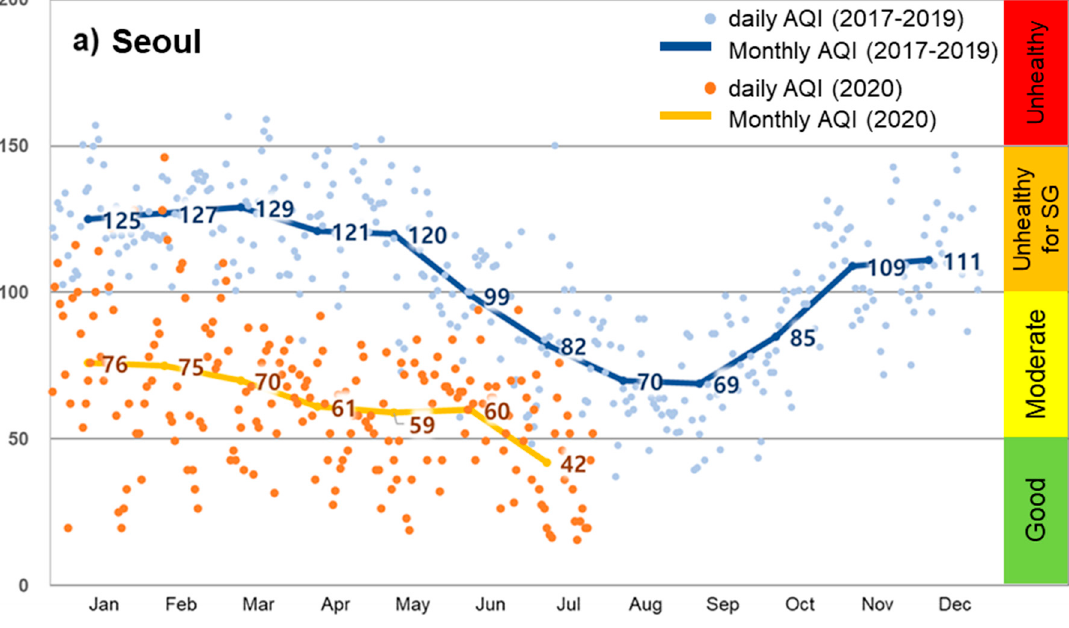
Figure 7. Comparison of daily and monthly air quality index (AQI) between 2020 and the previous three years ( a : Seoul, b : Daegu). Categories of the AQI are “good” (green, 0–50), “moderate” (yellow, 51–100), “unhealthy for sensitive groups (SG)” (orange, 101–150), and “unhealthy” (red, 151–200). “Very unhealthy” (purple, 201-300) and “hazardous” (maroon, 301–500) were not observed in this study. We identified the major pollutants affecting the AQI. The distributions of the indicatory pollutants according to each AQI class before and after social distancing are shown in Table S2 and